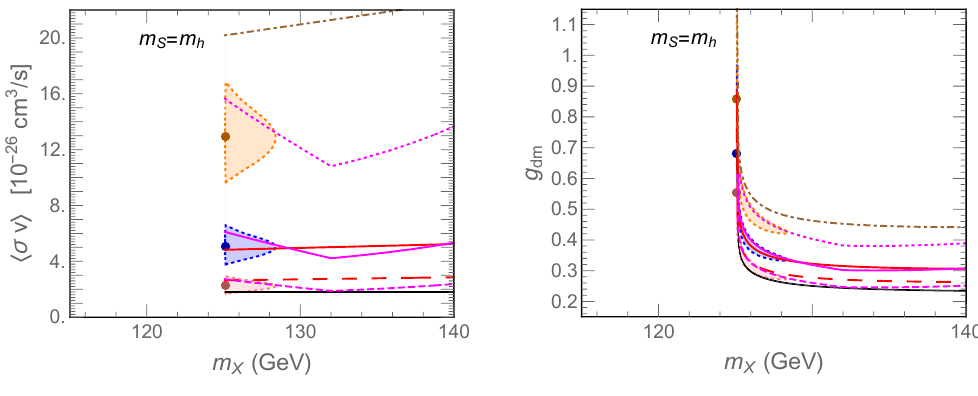
Figure 11 . Same as (cid:12)gure 10 but for m S = m h